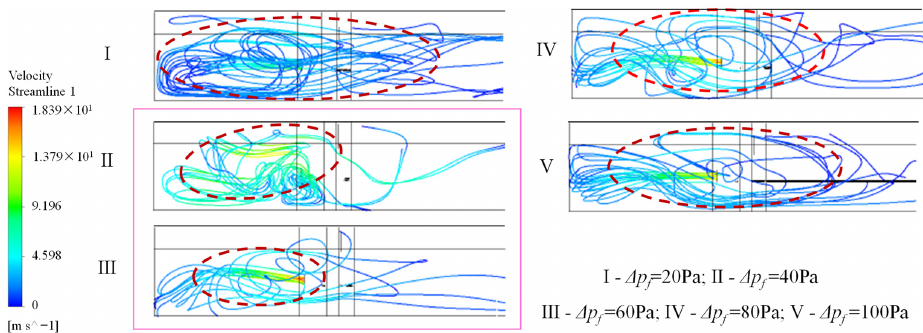
Figure 9. Streamlines of the single-heading tunnel under different I.D. fan differential pressure; the dotted lines indicate the size of swirls, and the two trials in the pink rectangle reach the minimum size of swirls (50 lines for each, and the streamlines’ color represents the flow velocity). The effect of the three most commonly used Φ fad (Factor E) in real work on the MAA of single-heading tunnels was studied. The 600 mm diameter duct will result in the worst